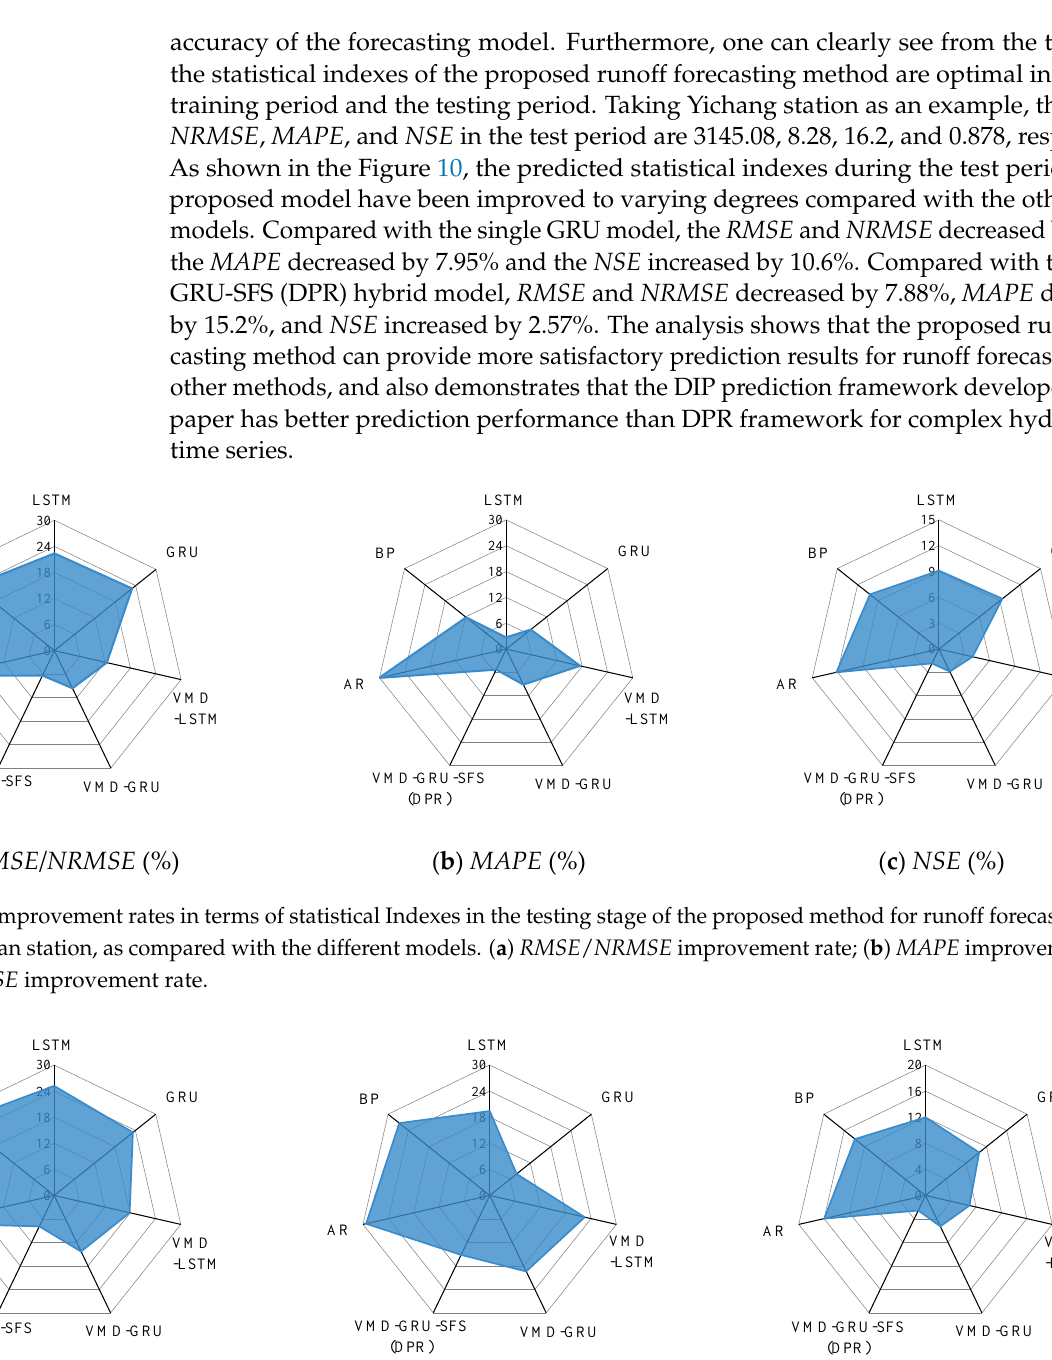
Table 3. Results of different forecasting methods for the Pingshan station.